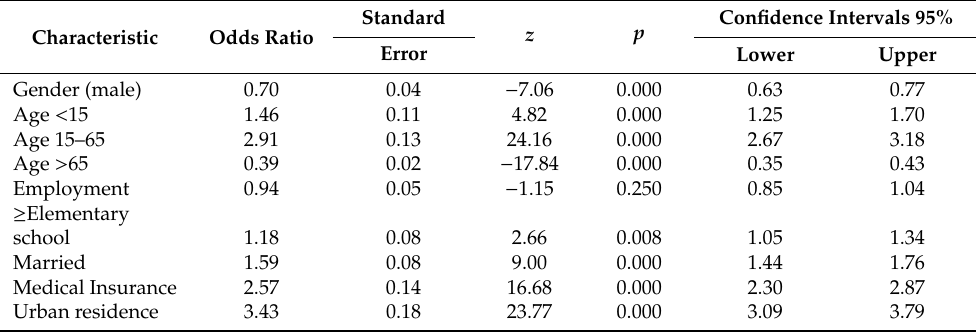
Figure 2. Distribution of mortality due to asthma in Mexico between 2010 and 2018 by diagnosis and age group ( n = 12,483). Table 2. Association between sociodemographic characteristics and the odds of receiving in-hospital attention at the time of death in Mexico between 2010–2018 ( n = 12,483).